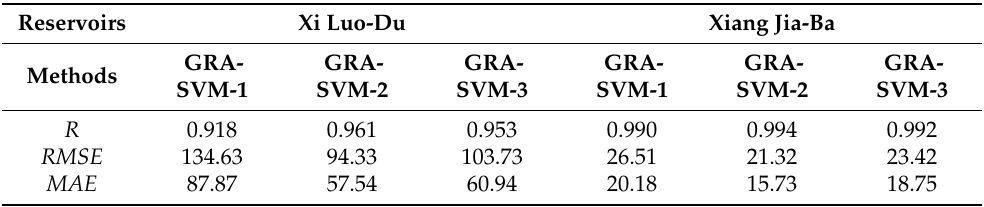
Table 3. The results of three schemes in regression